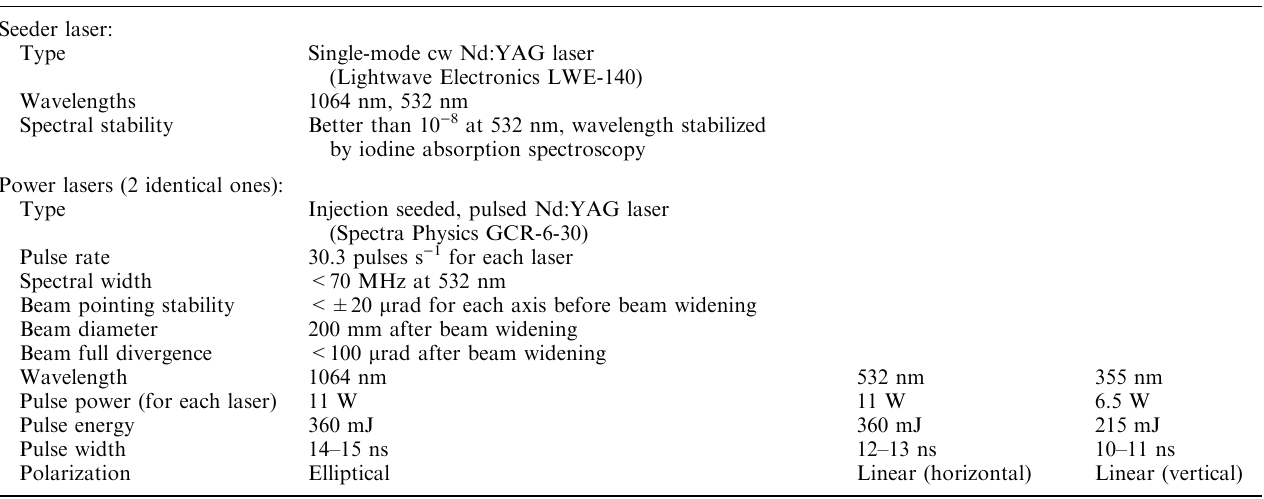
Table 2. Parameters of the RMR lidar transmitter Seeder laser: